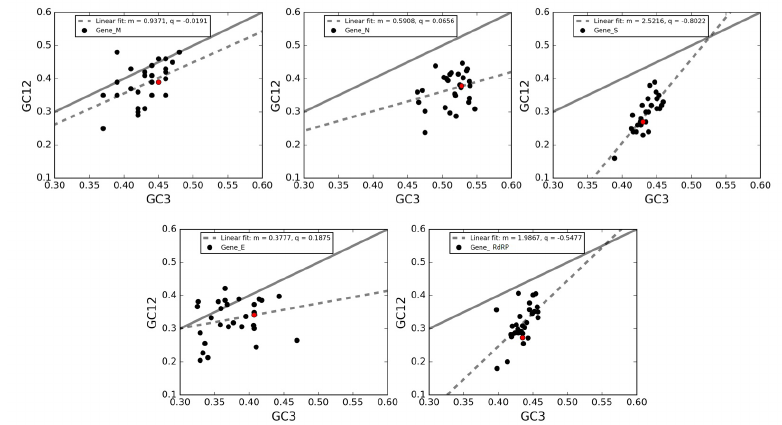
Figure 7. Neutrality plot of genes M, N, S, E and RdRP . In these plots, each point corresponds to a single gene in a virus. The solid black lines in all panels are the bisectors corresponding to those CUBs occurring merely due to mutational bias (no selective pressure). The black-dotted lines are the linear regressions. Red dots represent SARS-CoV-2